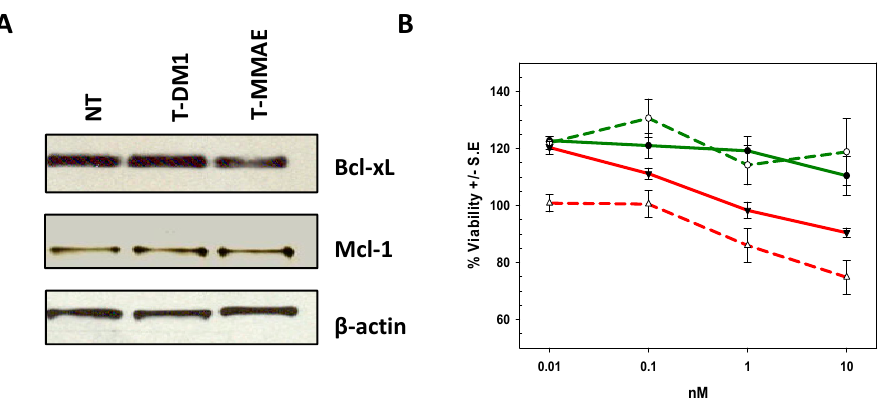
Figure 6. ( A ) Western blot analysis of the expression of Bcl-xL and Mcl-1 in untreated (NT) HCC1419 cells or cells surviving T-DM1 or T-MMAE treatment. β -actin levels were monitored to ensure equal loading; ( B ) Cytotoxicity of T-DM1 (red) or T-MMAE (green) in the presence (dashed lines) or absence (solid lines) of ABT-737 against HCC1419 cells that survived T-DM1 (red) or T-MMAE (green) treatment.